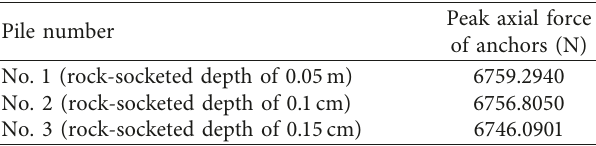
Table 6: Peak axial force of anchors with different rock-socketed depth depths.